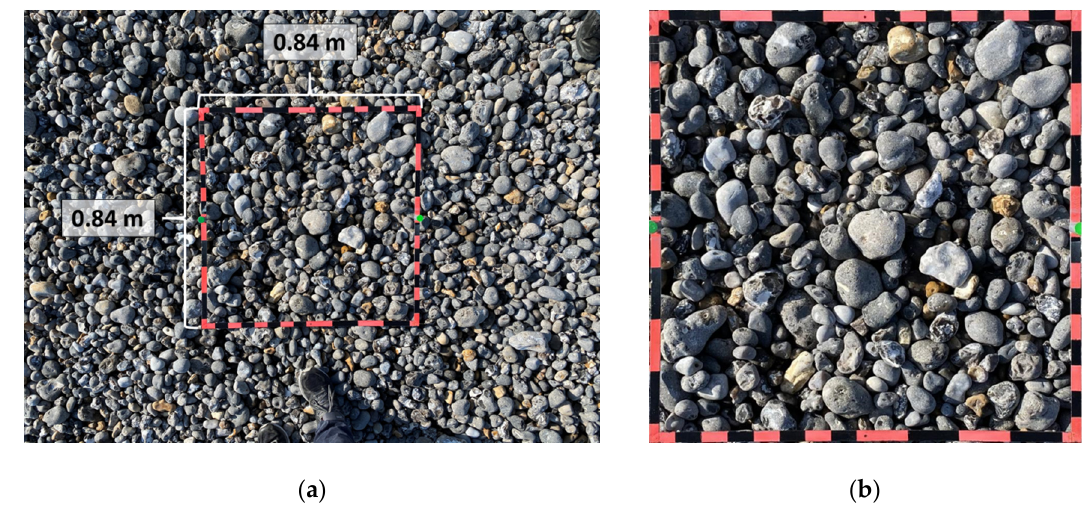
Figure 1. Example of a close-range top view image of a pebble ridge including a scaling quadra structure ( a ) before and ( b ) after orthorectification.